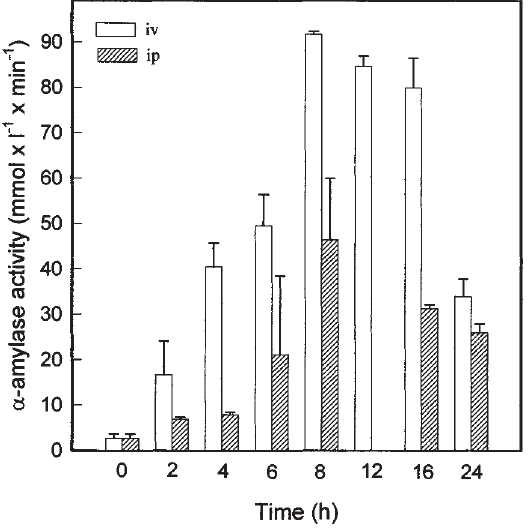
Fig. 3. Time course of (cid:11) -amylase activity (mmol/l (cid:2) min) in the serum of rats after iv medication of cerulein (5 (cid:22) g/kg/h) through a jugularis catheter (white columns) and after ip application of cerulein (10 (cid:22) g/kg/h) (lining columns). The development of cerulein pancreatitis after injections of cerulein every hour was monitored on the serum amylase activities for a period of 24 h. Maximal values were reched after 8 h. Thereafter serum amylase levels decreased slowly up to 24 h in spide of further supramaximal stimulation by cerulein. The time of highest serum amylase values corresponds with the strongest interstitial oedema of the pancreas and highest vacuolization of pancreatic acinar cells.